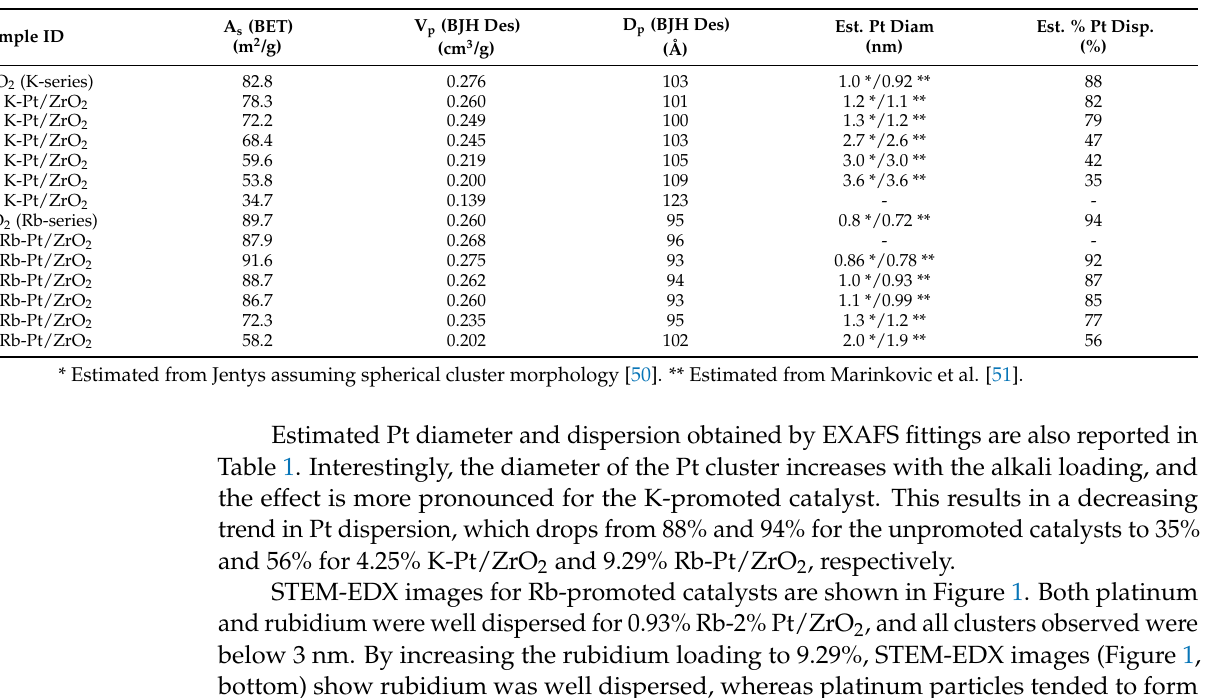
Table 1. Surface area, porosity, and Pt particle size for K and Rb-promoted catalysts (adapted from [48,49] with permission from Elsevier (copyright, 2020) and MDPI (copyright, 2021)).